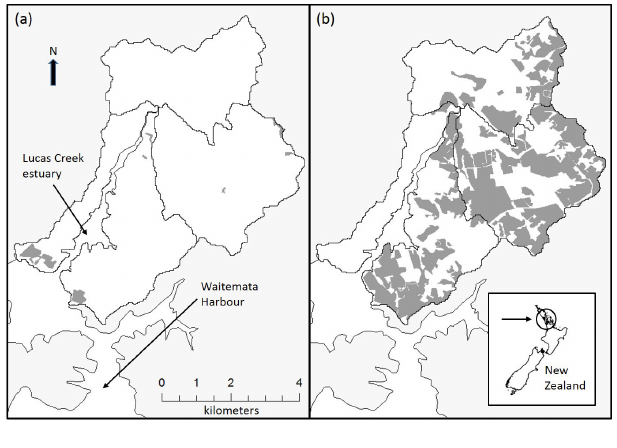
Fig. 5 . Lucas Creek catchment boundary, subcatchment boundaries, and estuary, showing extent of urban land cover (shaded dark grey) in (a) 1960 and (b)